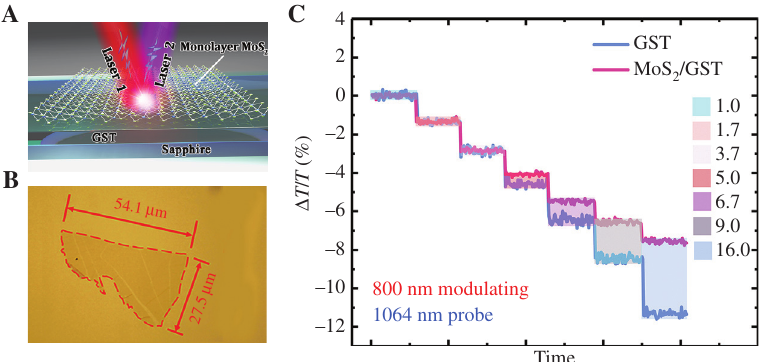
Figure 1: Characterization and schematic diagram of the MoS 2 (A) Principal schematic diagram of dual-light modulating probe experiments. In this system, 800 nm femtosecond laser 1 was used as a switching laser to change the GST state. Another laser 2 was used to probe the transmission of materials or excite the PL. (B) Optical photograph of the MoS /GST heterostructure. The height of GST was about 73 nm. (C) Relative transmittance changes of GST and the MoS 2 GST heterostructure under 1064 nm laser probe, in which the state of GST was modulated by 800 nm femtosecond. In this process, the fluence of 800 nm laser varied from 1 to 16 mJ/cm 2 and the fluence of 1064 nm laser was fixed at 0.2 mJ/cm 2